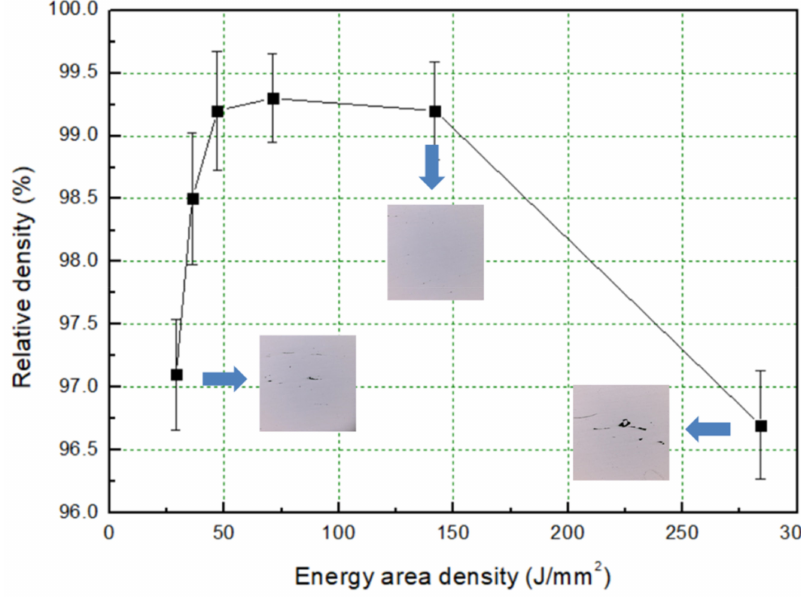
Figure 5. Evolution of the relative density of SLM low-alloy steel with